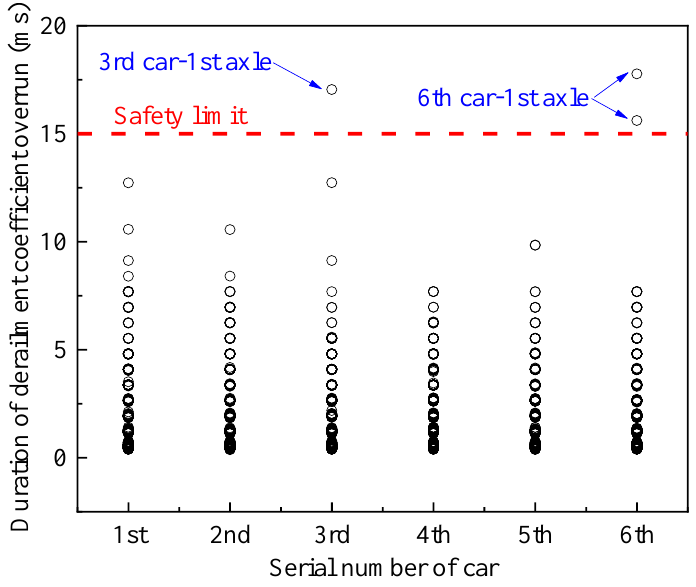
Figure 16. Wheel-rail lateral force and axle lateral force in the time domain.